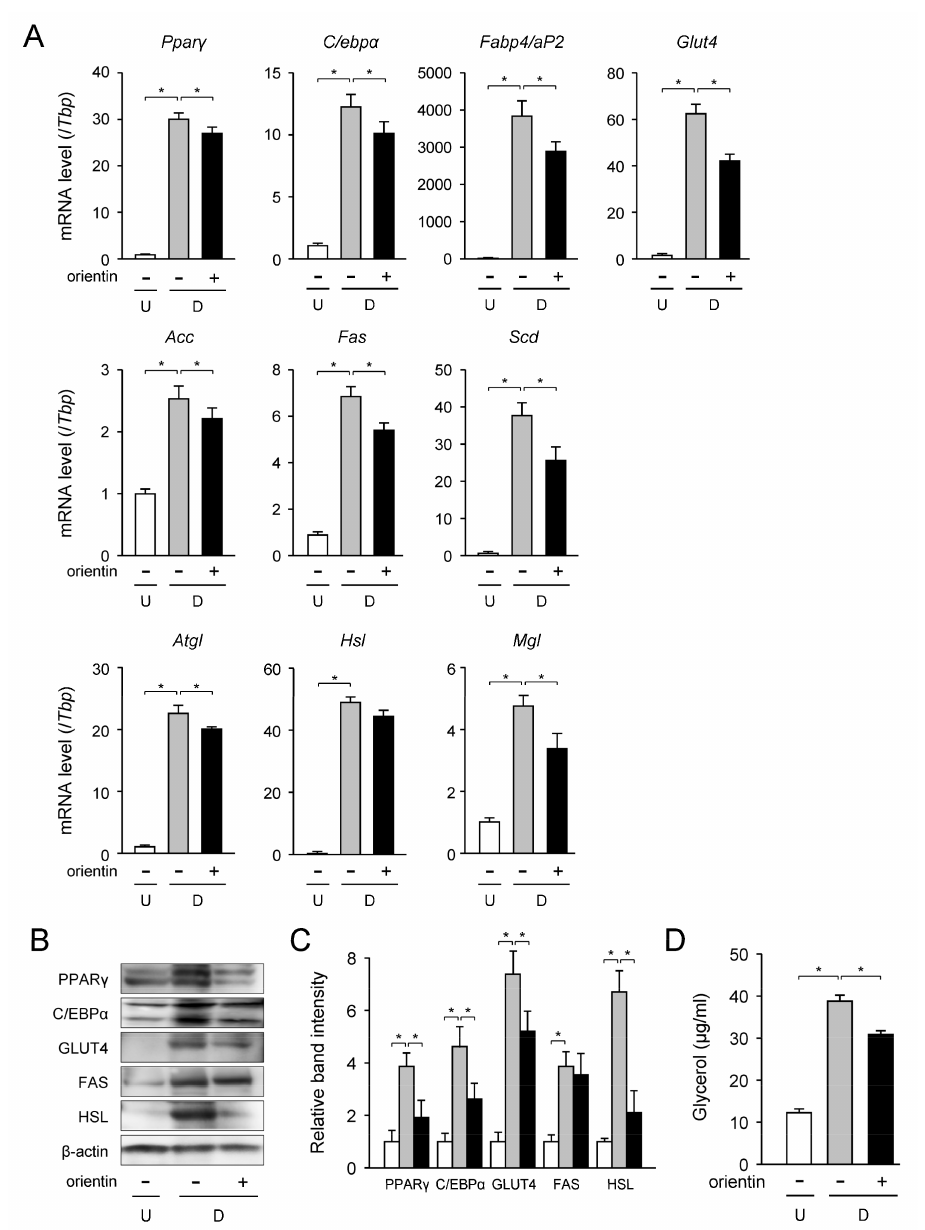
Figure 2. Change in expression level of adipogenic, lipogenic, and lipolytic genes/proteins by orientin. ( A ) The mRNA levels of the adipogenic, lipogenic, and lipolytic genes in orientin-treated 3T3-L1 cells. Undifferentiated 3T3-L1 cells (U; white columns) were differentiated into adipocytes (D; gray columns) for 6 days in medium with orientin (50 µ M; black columns). The data are represented as the means ± S.D. from three experiments. * p < 0.01, as shown by the brackets; ( B ) Change in protein expression level by orientin. 3T3-L1 cells were caused to differentiate as described in the legend of Figure 2A. For Western blot analysis, 15 µ g protein was loaded in each lane. Data are the representative of three experiments. Each band intensity was normalized with that of β -actin; ( C ) Measurement of intensity of band shown in Figure 2B. Data are shown as the means ± S.D. from three experiments. * p < 0.01, as shown by the brackets; ( D ) Decrease in glycerol release by orientin. Data are represented as the means ± S.D. from three experiments. * p < 0.01, as shown by the brackets. The protein levels of some of these genes were examined by Western blot analysis. The protein levels of adipogenic PPAR γ , C/EBP α , GLUT4, lipogenic FAS, and lipolytic HSL were elevated